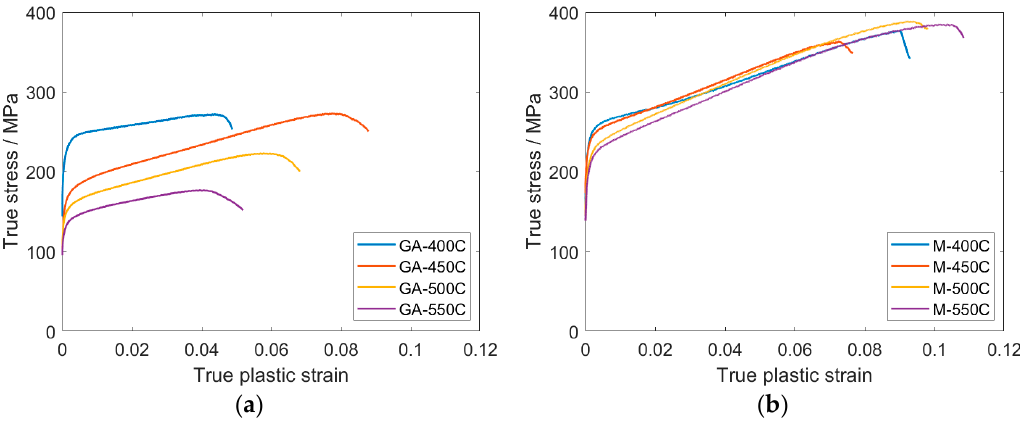
Figure 6. Representative true stress—true strain curves for ( a ) gas-atomized and ( b ) milled samples measured in compression.